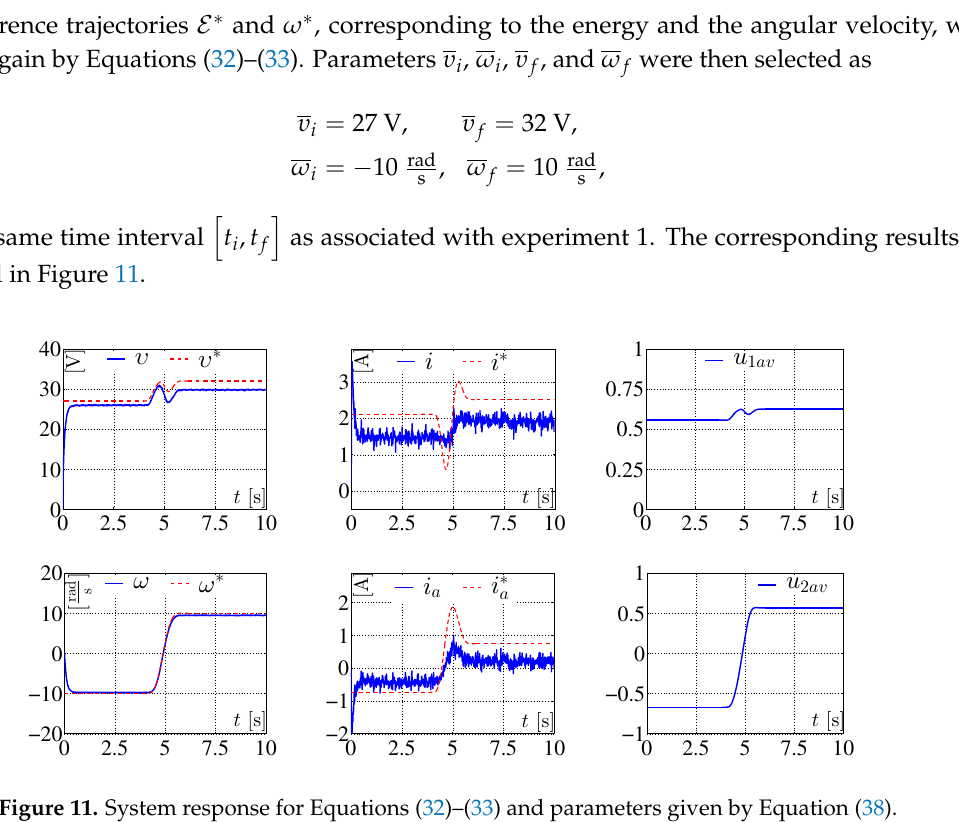
Figure 11. System response for Equations (32)–(33) and parameters given by Equation